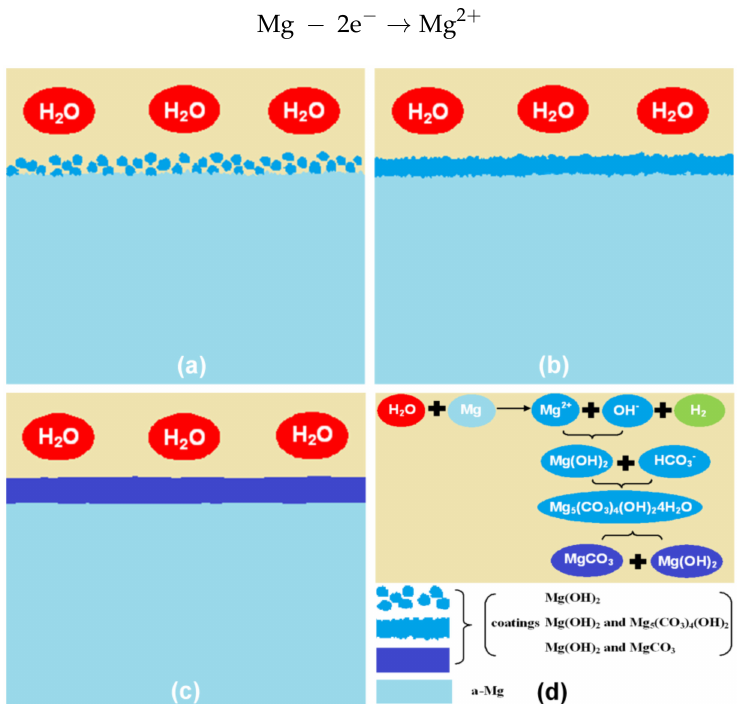
Figure 4. Schematic representation of the suggested coating formation mechanism: ( a ) nucleation; ( b ) transformation; ( c ) densification; ( d ) overall coating formation